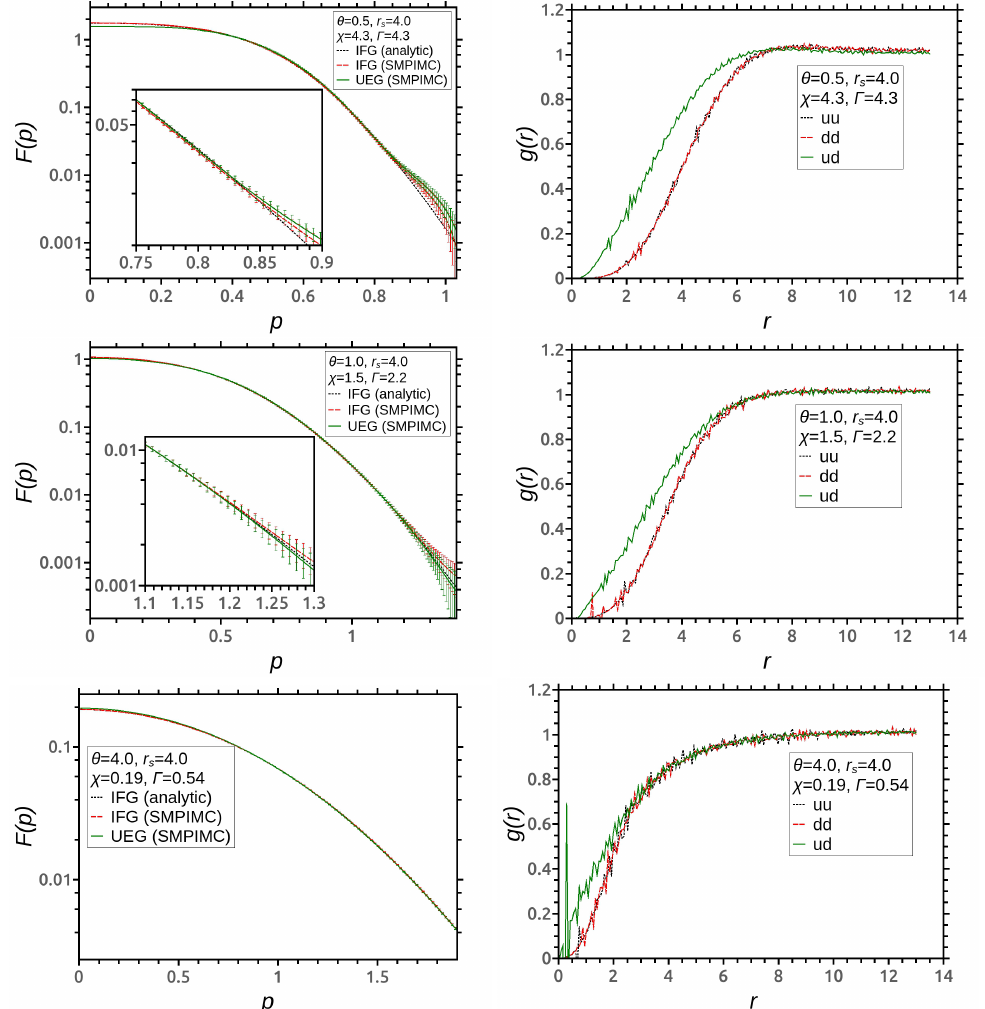
Figure 1. Left plots: single-particle momentum distribution functions of the unpolarized UEG at r s = 4.0 and θ = 0.5,1,4 calculated with the SMPIMC method. The results are compared with the SMPIMC results for the IFG in the same conditions and with the analytical Fermi distributions. Right plots: the pair correlation functions g uu , g dd , and g ud of the